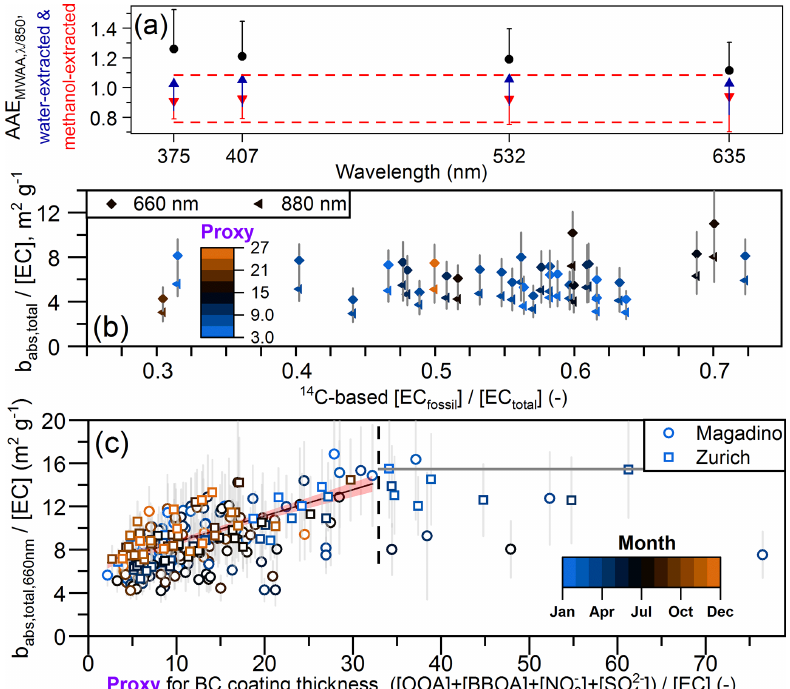
Figure 4. (a) AAE of bare BC for nine different samples from both sites and seasons, measured with MWAA upon water and (sequential) methanol extraction for the removal of soluble BrC and coatings using 850nm as reference wavelength. The error bars indicate 1 SD from all samples. The dashed red lines are a guide for the eye for the obtained range ( ± 1SD) from all wavelengths upon methanol extraction. (a) As- sessment of possible source-related MAC BC variability at 660 and 880nm (colour-coded with the proxy; see x axis in c ), where extractable BrC does not contribute to particulate absorption, for year-long Magadino filter samples measured for 14 C in the EC fraction, relevant also for the application of the aethalometer SA model. R 2 for 660nm is 0.11 ( p = 0 . 06) and 0.16 for 880nm ( p = 0 . 02). (c) Calculation of MAC bareBC (Fig. S14) as the intercept of uncertainty-weighted linear regression of MAC BC , 660nm vs. a proxy for the BC coating thickness for proxy < 33. Intercept: 6.3 ± 0.3m 2 g − 1 ; slope: 0.242 ± 0.019m 2 g − 1 ; Pearson’s r = 0 . 64. The grey line for larger proxy values indicates the upper limit ( + 1SD) of the observed MAC BC in this (lensing saturation)